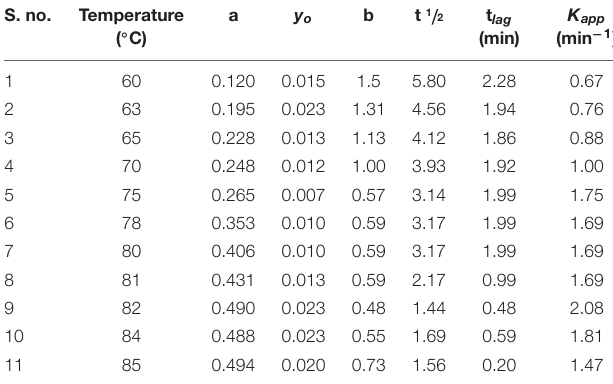
TABLE 5 | Change in kinetic parameters associated with BSA aggregation in the presence of fixed concentration (1 molar) of monosodium glutamate at different temperatures ranging from 60 to 85 ◦ C.